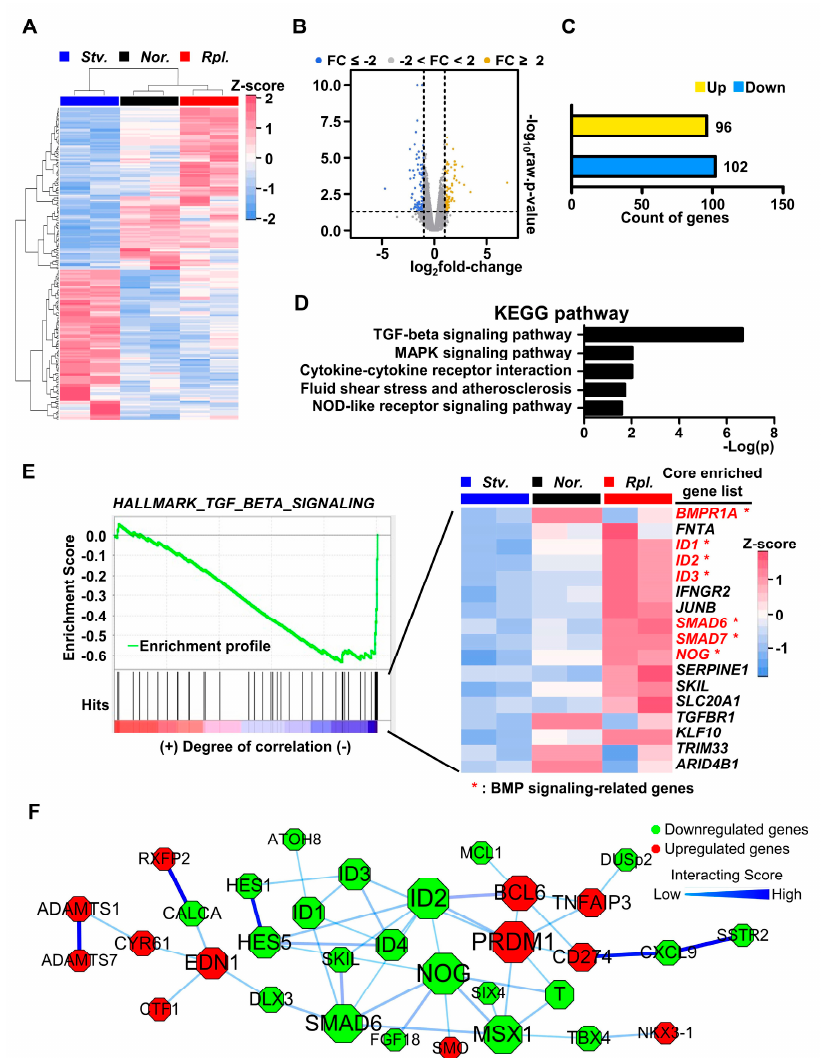
Figure 2. Nutrient starvation represses bone morphogenetic protein (BMP) signaling pathway in GLUTag cells. ( A ) Clustering of transcriptome analysis of starvation differentially expressed genes (DEG) versus normal and replenishment DEG. ( B ) Volcano plot of starvation DEG versus normal and replenishment DEG ( C ) Up- and down-regulated DEG of starvation normalized by DEGs of normal and replenishment. ( D ) KEGG pathway of DEG of starvation. ( E ) Gene set enrichment analysis with heatmap of core enriched gene expression profiles. ( F ) Functional protein association network analysis using STRING.